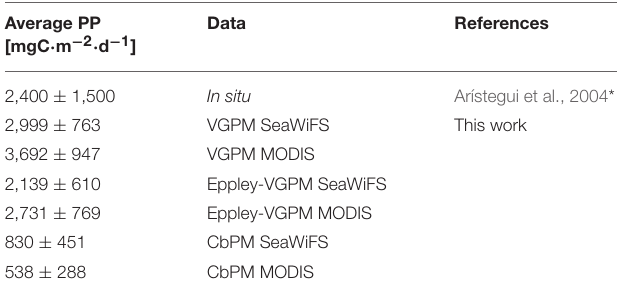
TABLE 4 | In situ PP measurements in coastal waters compared to model NPP estimates over the shelf (0–200m), for 31.5–18 ◦